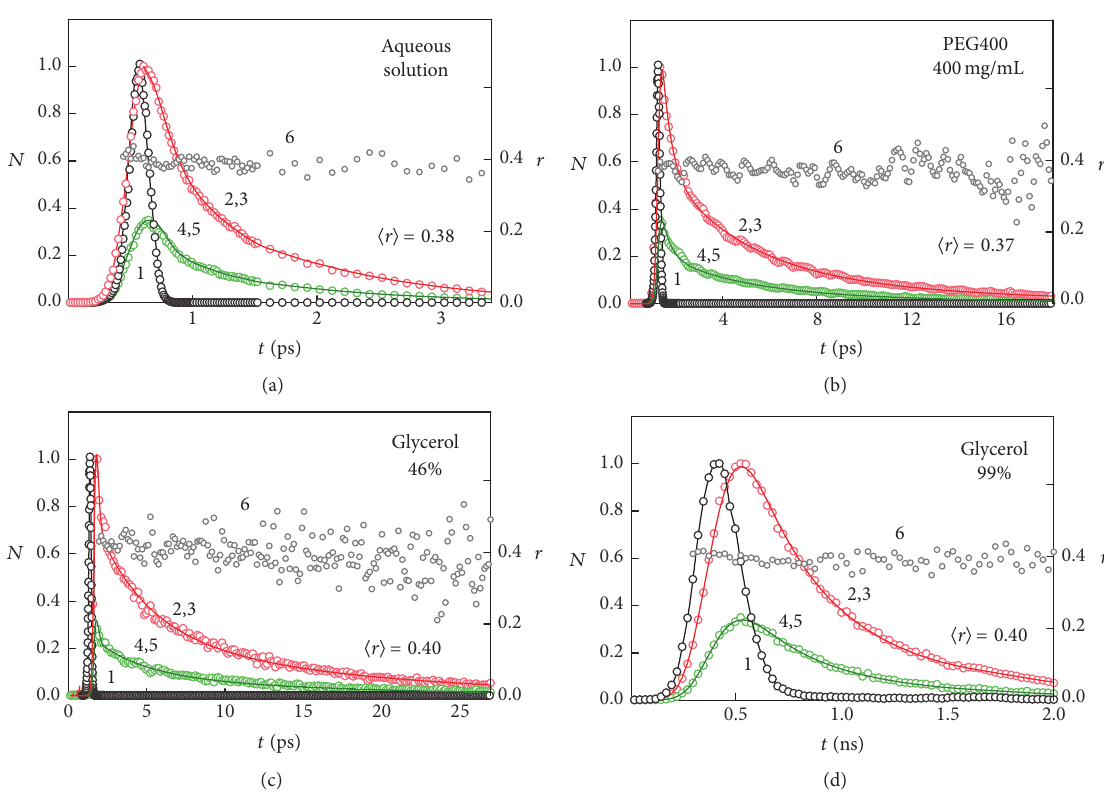
Figure 4: Fluorescence anisotropy of ThT in aqueous solution, in aqueous-glycerol solutions, and in aqueous solutions in the presence of crowding agents. The excitation laser impulse profile (1) , the experimental and best-fit calculated decay curves of the vertical (2,3) and horizontal (4,5) components of the fluorescence excited by vertically polarized laser impulses at 420 nm and the change in fluorescence anisotropy over time (6) for ThT in aqueous solution (a), ThT in aqueous solution in the presence of PEG-400 in concentration 400 mg/mL (b), ThT in aqueous solution in the presence of 46% glycerol (c), and ThT in aqueous solution in the presence of 99% glycerol (d) are shown. 𝑁(𝑡) is the number of registered impulses in the time interval (𝑡+Δ𝑡) normalized to unity in the maximum. The data presented on (a), (b), and (c) were obtained with the use of spectrometer FOG100 and the data presented on (d) were obtained with the use of spectrometer FluoTime